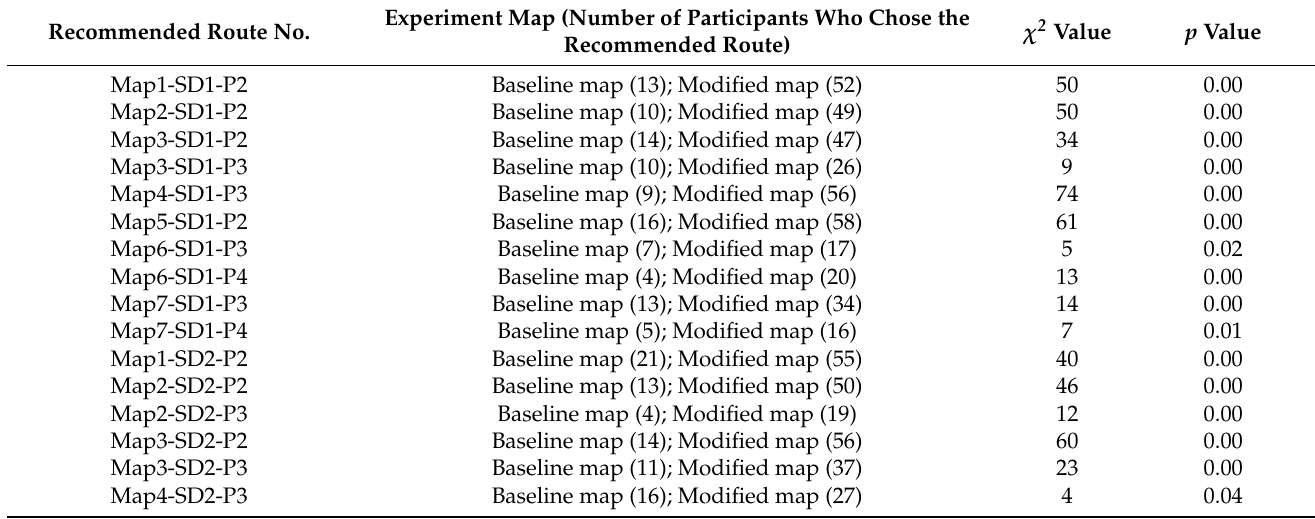
Table 1. Results of the Chi-square test.